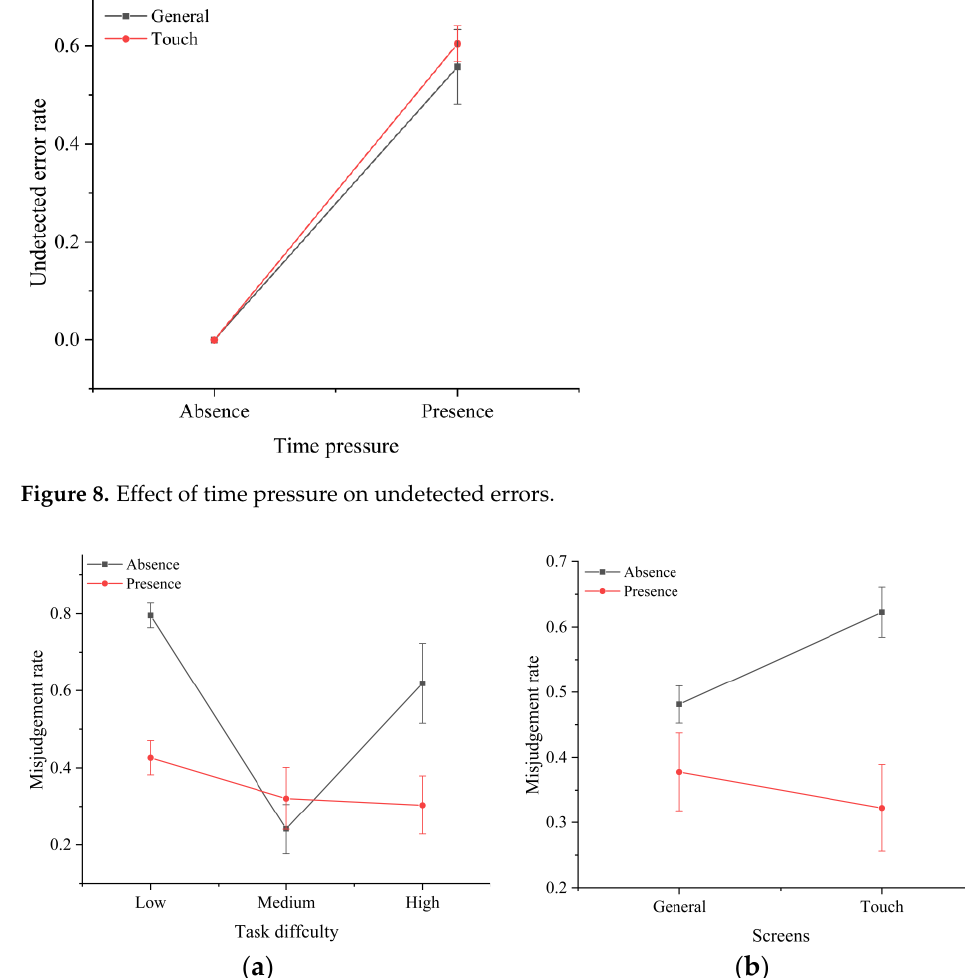
Figure 9. Interaction effects between the ( a ) task difficulty and time pressure and ( b ) screen type and time pressure on misjudgment.